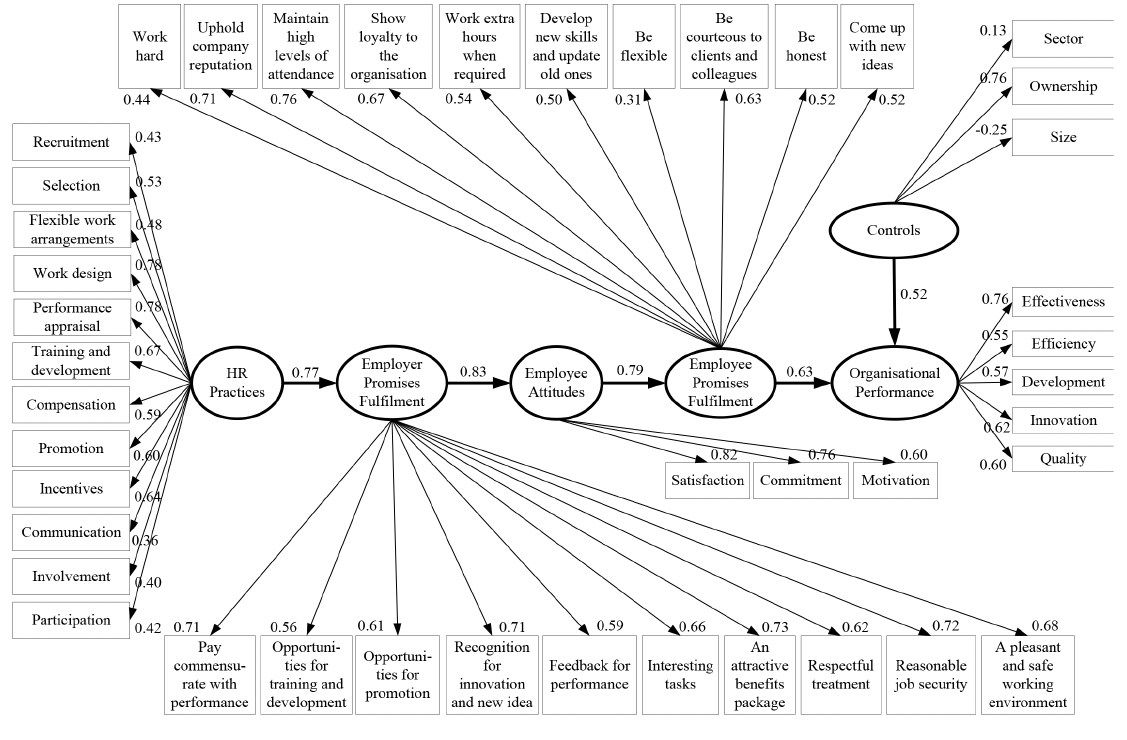
Figure 3. Estimation results of the hypothesized model for year 2010